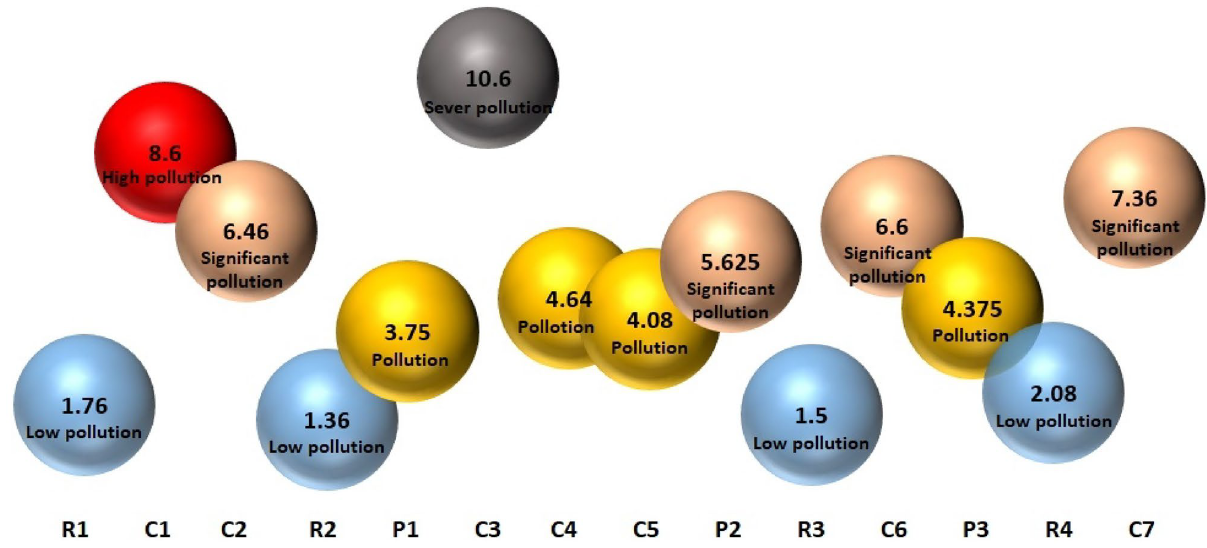
Figure 3. Calculated CBPI for studied